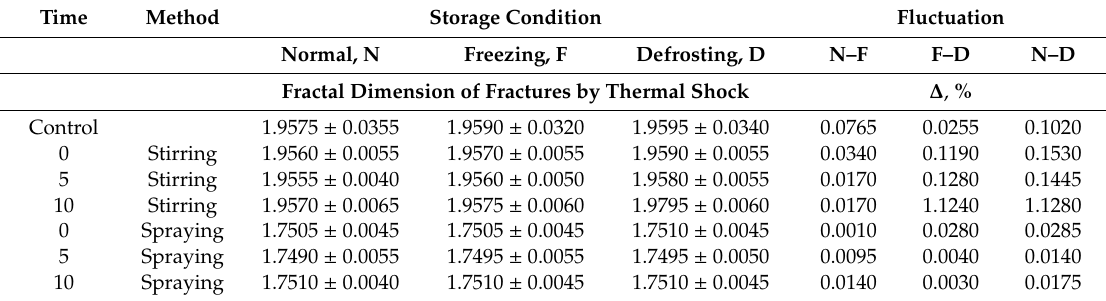
Table 7. Descriptive analysis for the fractal dimension of fractures by thermal shock of non-wood pellets with addition by stirring or spraying of liquid-state food waste subjected to the process of